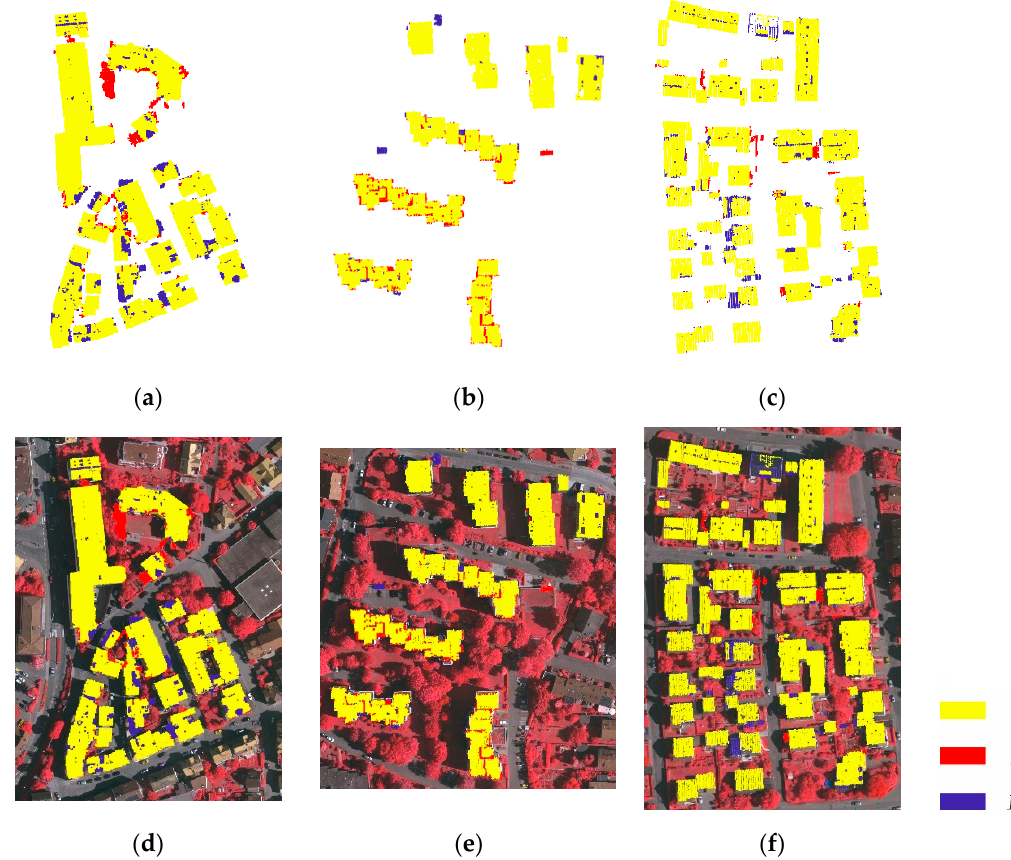
Figure 5. Building extraction results of the proposed method. ( a ) Extraction results for Area1; ( b ) extraction results for Area2; ( c ) extraction results for Area3; ( d ) the extraction results of Area1 integrating with the corresponding orthophoto image; ( e ) the extraction results of Area2 integrating with the corresponding orthophoto image; ( f ) the extraction results of Area3 integrating with the corresponding orthophoto image. Yellow represents correctly extracted buildings ( TP ), red represents wrongly extracted buildings ( FP ), and blue represents omitted buildings ( FN ).